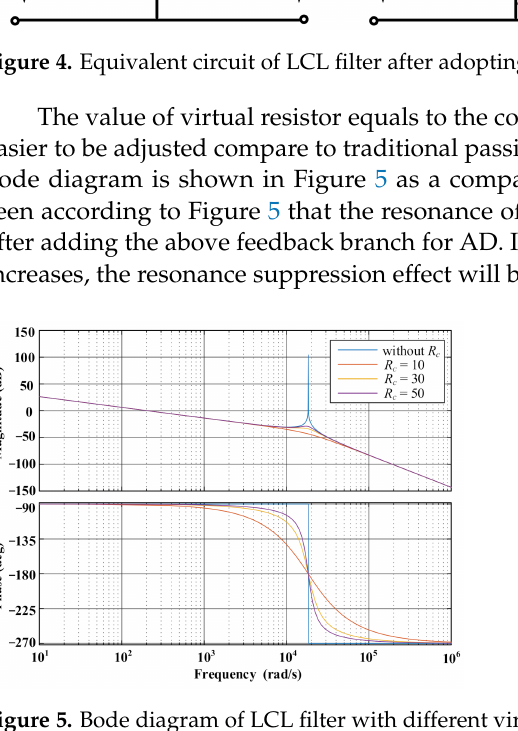
Figure 5. Bode diagram of LCL filter with different virtual damping resistors R c